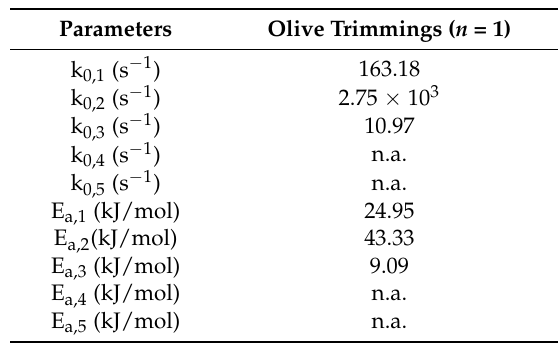
Table A3. Pre-exponential factors and activation energies evaluated using the Arrhenius plot for the HTC reactions for olive trimmings fixing n = 1 (n.a. = not available due to mathematical constraints: k 4 resulted almost zero for T = 180 ◦ C, such that ln(k 4 ) became extremely low—Figure A4—and not scientifically sound; the value of k 5 was found to decrease with temperature—Figure A4, Table A2—so the value of E a,5 became mathematically negative, which has no physical